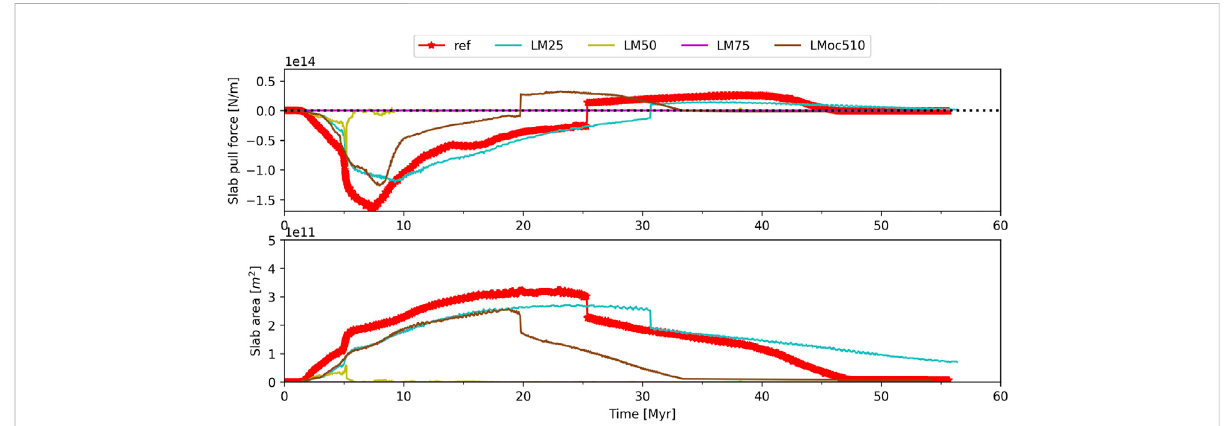
FIGURE 9 Temporal evolution of slab pull and slab area for the reference model and varying degrees of frictionally weakened lithospheric mantle (25, 50, 75, and 50% in combination with a 510 km ocean). 50% weakening or more results in slab detachment immediately after the push is stopped. Interestingly, combining 50% weakening with a slightly shorter ocean does not lead to premature slab